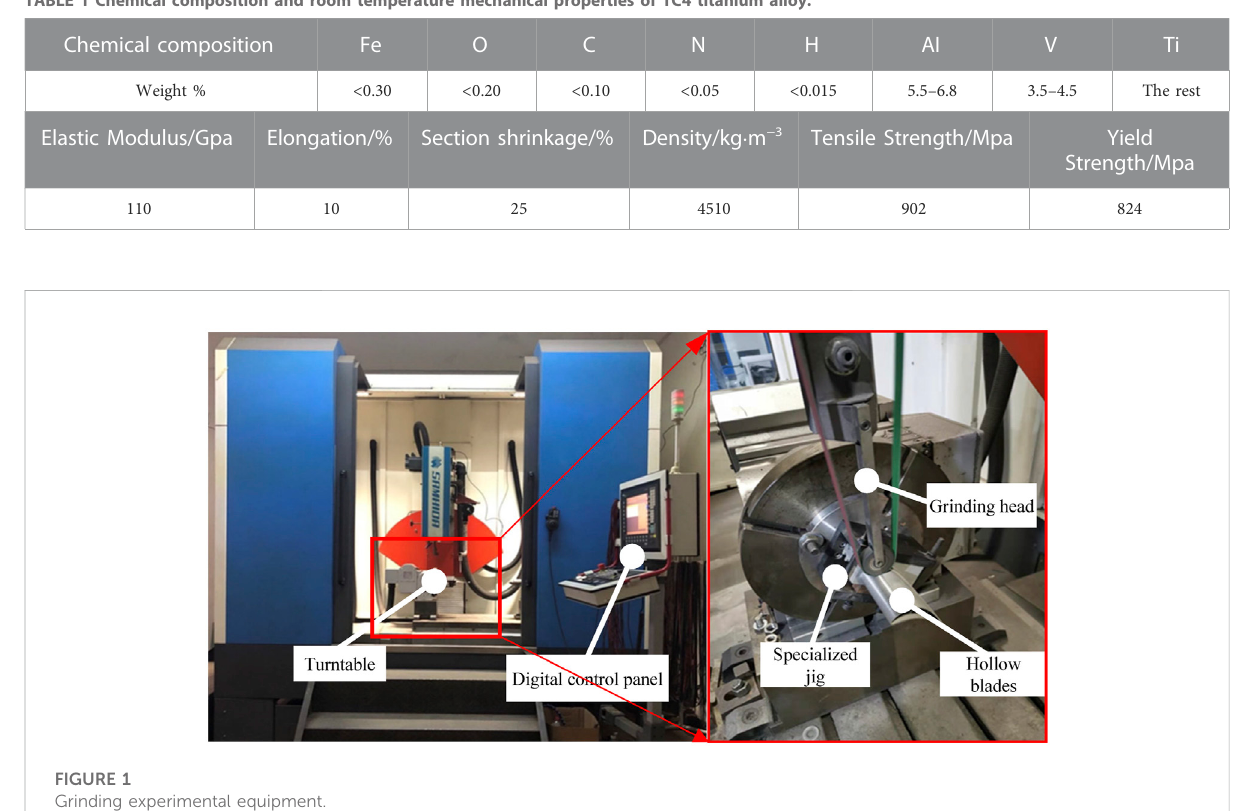
FIGURE 1 Grinding experimental equipment.